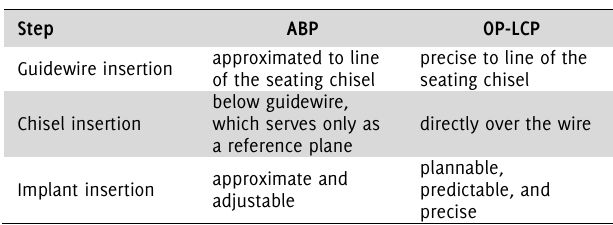
Table 1 . Procedural Comparison Between ABP and OP-LCP